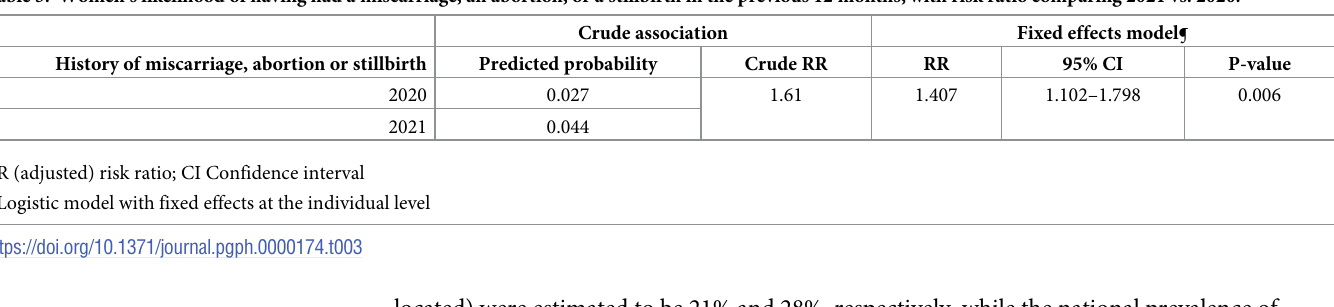
Table 3. Women’s likelihood of having had a miscarriage, an abortion, or a stillbirth in the previous 12 months, with risk ratio comparing 2021 vs.